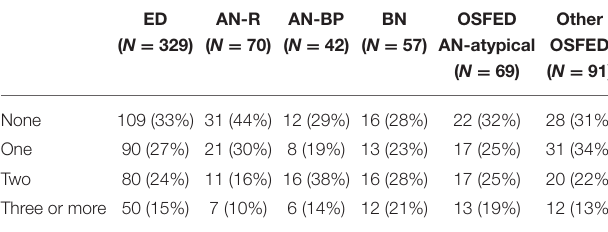
TABLE 2 | Prevalence of different types of traumatic experiences by diagnostic category (number of patients and percentage per category). AN-R